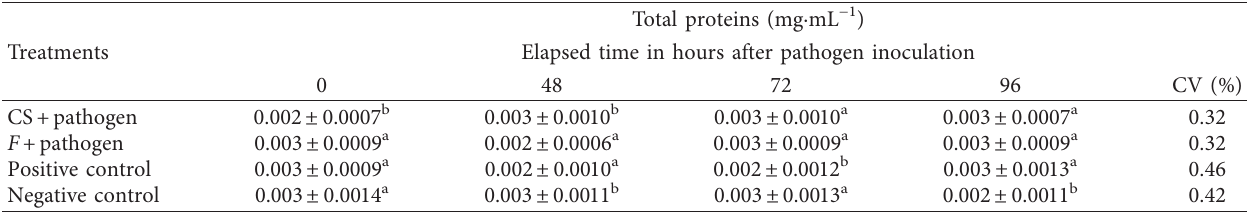
Table 2: Average total protein content of guarana leaves.